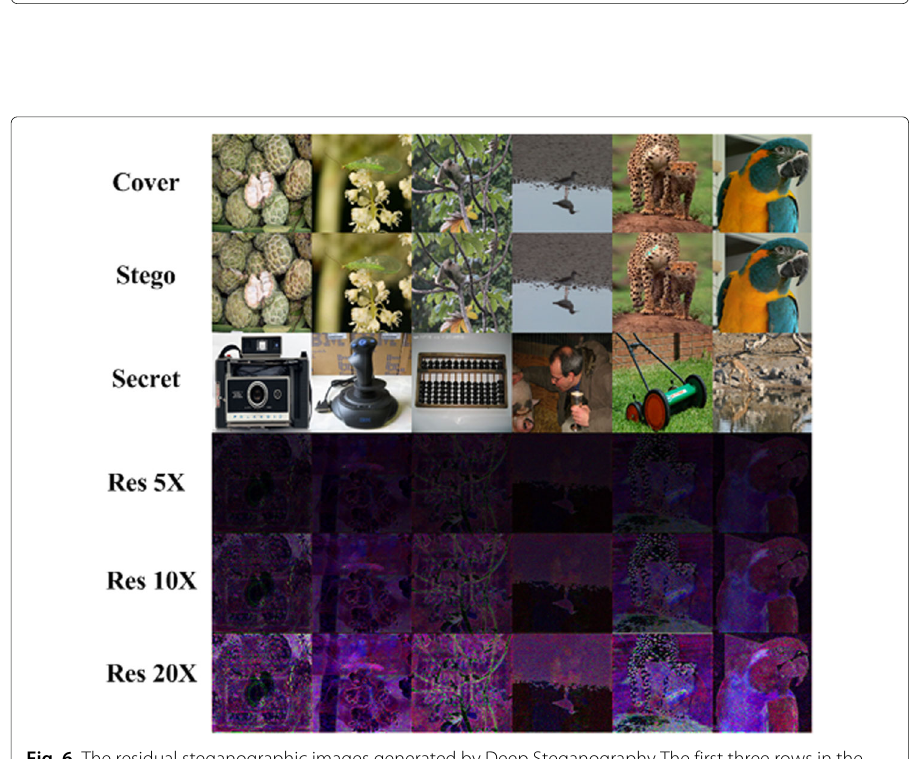
Fig. 6 The residual steganographic images generated by Deep Steganography The first three rows in the figure are the cover images, the corresponding steganographic images generated by Deep Steganography, and the secret images; the last three rows are the residual images obtained by the subtraction of the steganographic images and corresponding cover images with 5 × , 10 × , and 20 × enhancement,